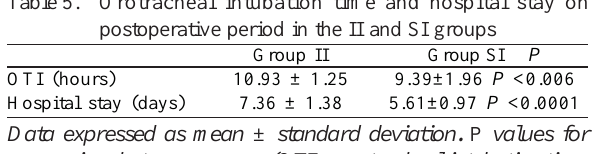
Table 5. Orotracheal intubation time and hospital stay